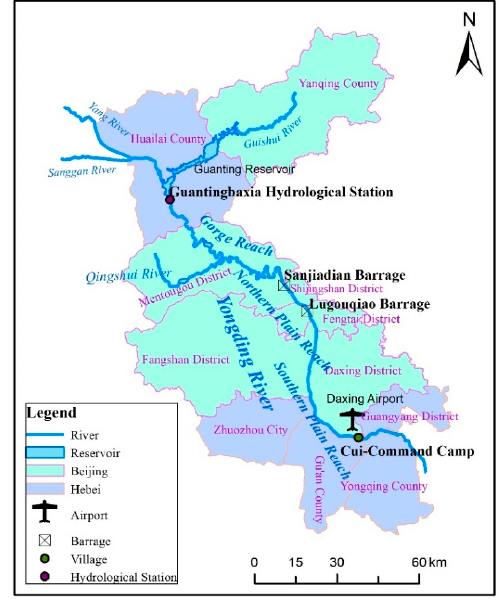
Figure 2. Location and distribution of Yongding